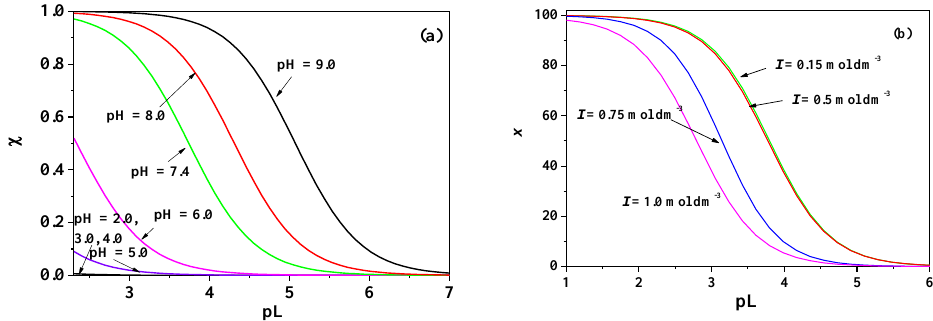
Figure 9. Sequestering diagram of dopamine towards Sn 2+ . ( a ) T = 298.15 K, I = 0.15 mol dm −3 and different pHs. ( b ) T = 298.15 K, pH = 7.4 and different ionic strengths. pL 0.5 values: ( a ) 1.30 (pH = 5.0) < 2.33 (pH = 6.0) < 3.74 (pH = 7.4) < 4.31 (pH = 8.0) < 5.07 (pH = 9.0). ( b ) 3.74 ( I = 0.15 mol dm −3 ) < 3.70 ( I = 0.50 mol dm −3 ) < 3.12 ( I = 0.75 mol dm −3 ) < 2.60 ( I = 1.0 mol dm −3 ).